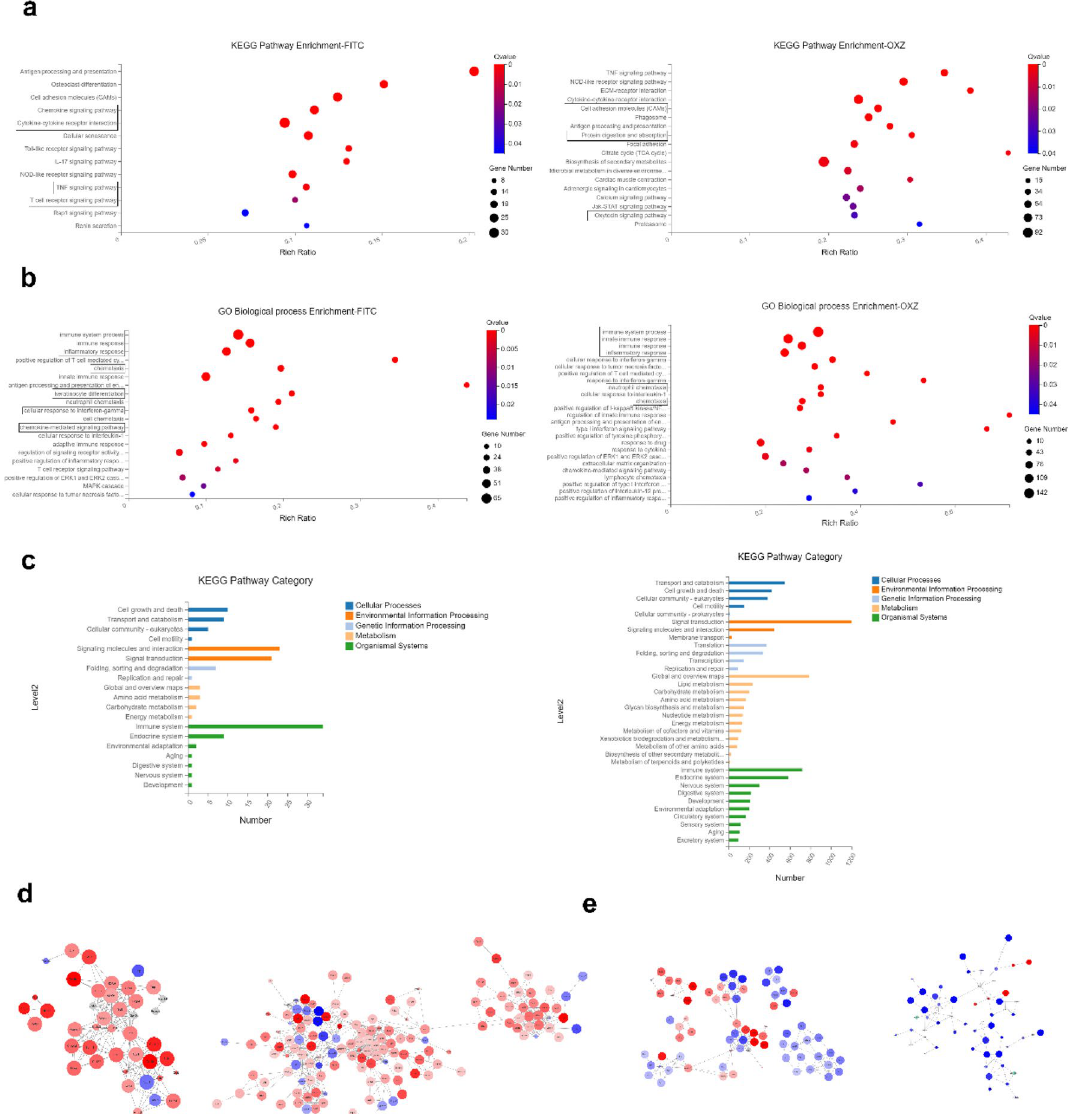
Figure 4. Kyoto Encyclopedia of Genes and Genomes (KEGG) pathway enrichment of different expression genes. ( a ) Kyoto Encyclopedia of Genes and Genomes (KEGG) pathway enrichment of different expression genes. The size of the bubble indicates the number of genes annotated to a particular KEGG Pathway. ( b ) Gene Ontology (GO) Biological Process enrichment of different expression genes. The size of the bubble indicates the number of genes annotated to a particular KEGG Pathway. ( c ) KEGG categories of different expression genes. ( d ) Protein–protein interaction (PPI) networks of predicted DEGs regulated by FITC or OXZ were assembled. Nodes were colored by fold changes between haptens-treated and control groups. ( e ) PPI networks of predicted DEGs in different models regulated by 7-Met were assembled. Nodes were colored by fold changes between 7-Met and haptens-treated groups. All PPI networks were assembled according to STRING database using Cystoscope 3.8.2 and the node size represents the enriched q-value value, the larger the node, the smaller the q-value (Supplementary Table